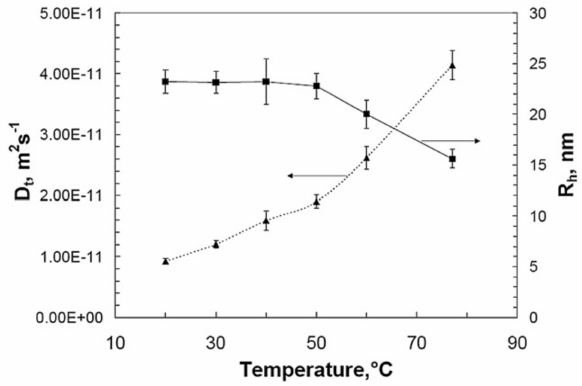
Figure 12. D t and R h of PVP polymer chains ( M w = (3.94 ± 0.12) × 10 5 g · mol − 1 ) as a function of temperature. Adapted with permission from [22]; published by Elsevier,